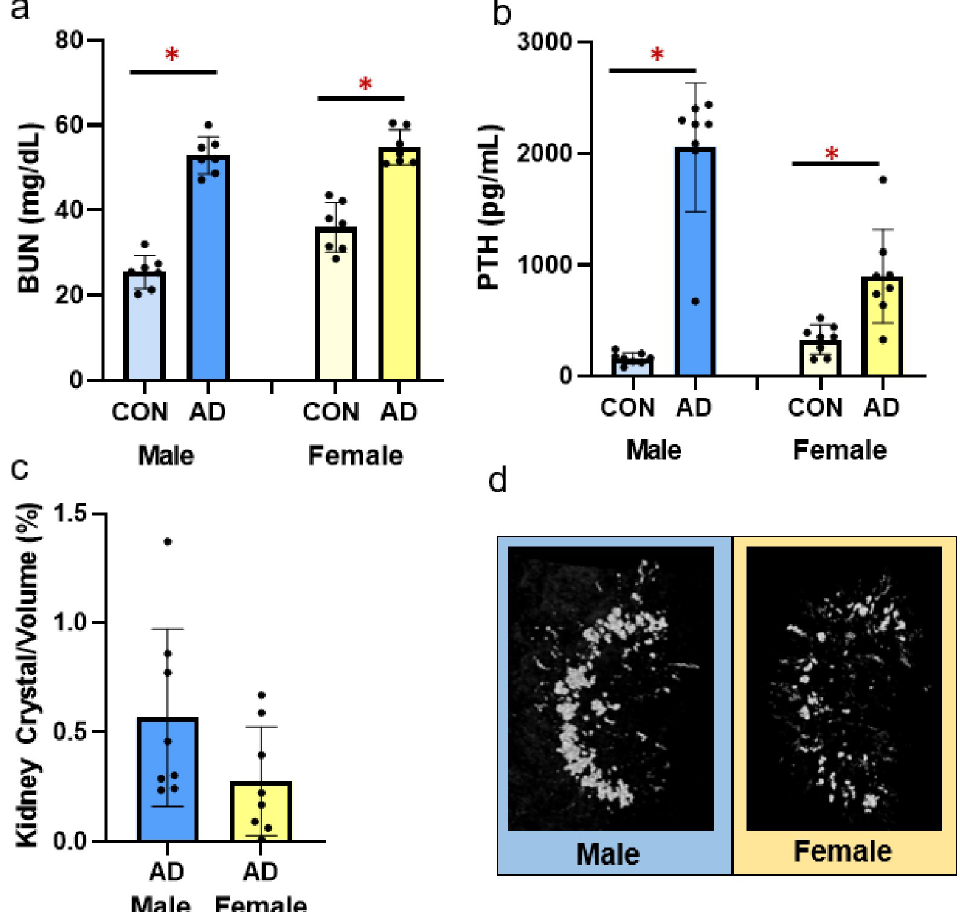
Fig 1. Serum BUN, serum PTH, and adenine kidney crystals in male and female adenine mice. A) Serum BUN was higher in both male and female adenine mice compared to sex-matched controls. B) Serum PTH was higher in adenine-induced CKD in both male and female mice compared to sex-matched controls. C) % kidney crystals present in adenine male and female mice from CT analysis. Control mice had no visible crystals. D) Representative images of kidney crystals in male and female adenine mice. Images represent values closest to the mean of each group. Error bars = standard deviation. � Indicates statistical difference (p < 0.05) from t-test between control and adenine within each